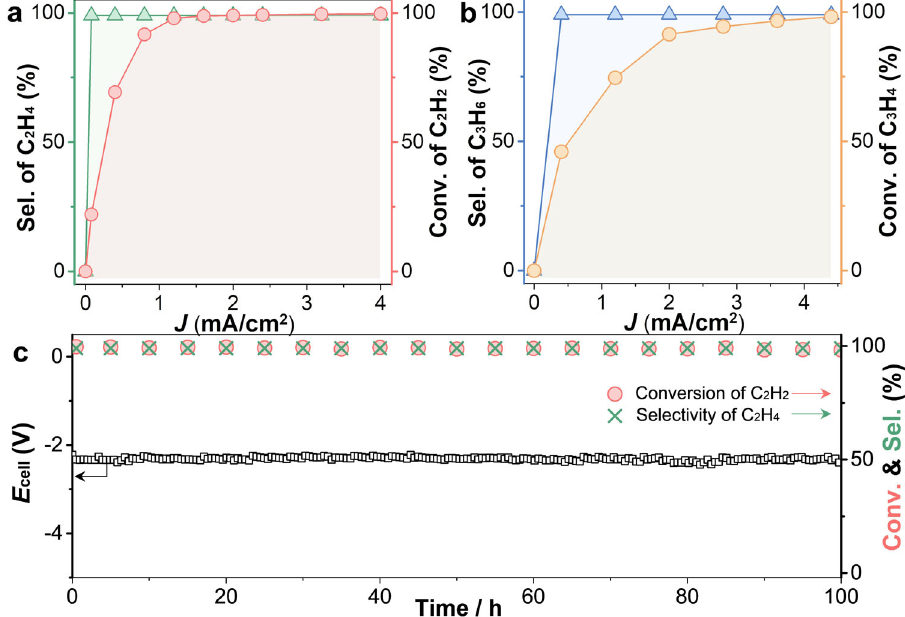
Fig. 4 EAH performance of NHC – Cu in crude ole fi ns using a large two-electrode fl ow cell (25 cm 2 ). a Acetylene conversion and speci fi c selectivity of ethylene as a function of current density at a fl ow rate of 10 mL/min in crude ethylene containing 1% acetylene. b Propyne conversion and speci fi c selectivity of propylene as a function of current density at a fl ow rate of 10 mL/min in propylene containing 1% propyne. c The 100 – h EAH durability test of NHC – Cu at 4 mA/cm 2